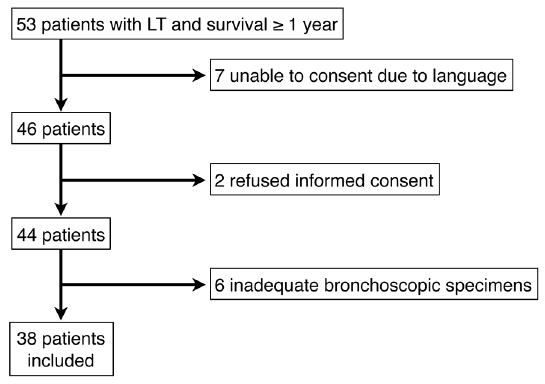
Figure 1. Study enrollment.